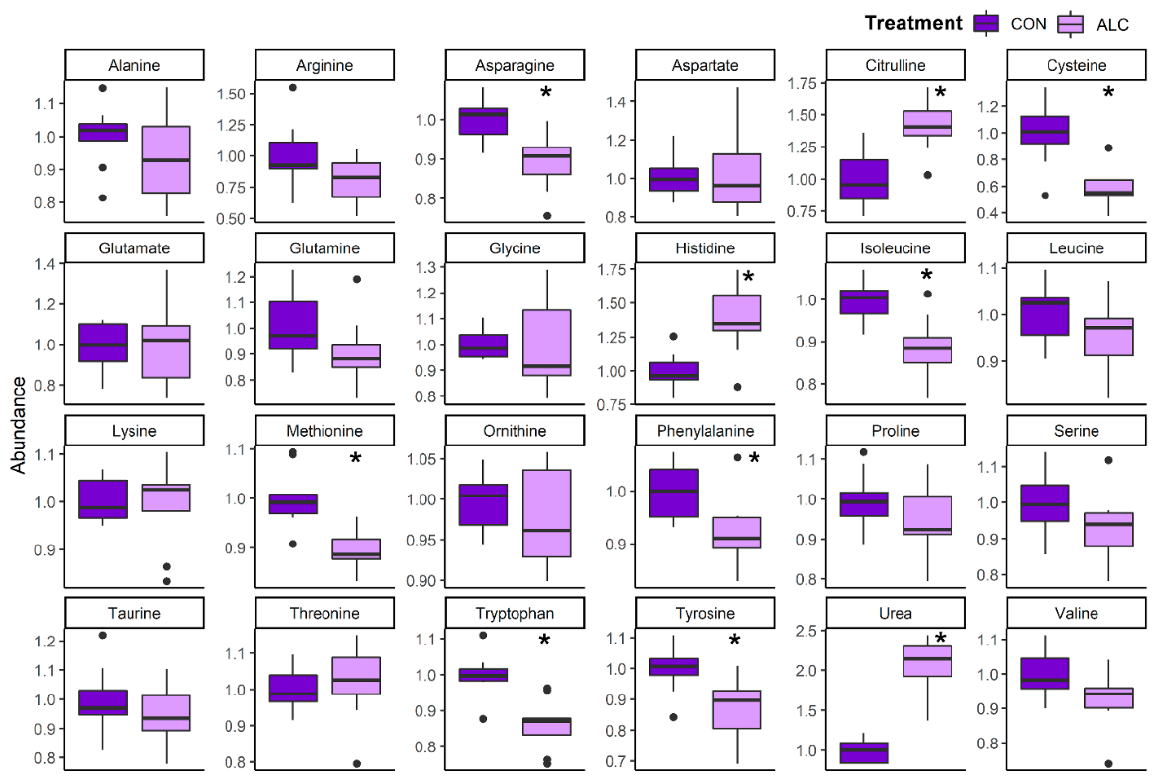
Figure 4. Relative abundance of amino acid metabolites in ALC vs. CON in maternal liver. Abun- dance in CON is normalized to 1.0, and comparisons used Wilcoxon test. Boxplots depict the data’s spread (measured in inter quartile range), middle line depicts the median, and the dots indicate outliers. * q ≤ 0.05.